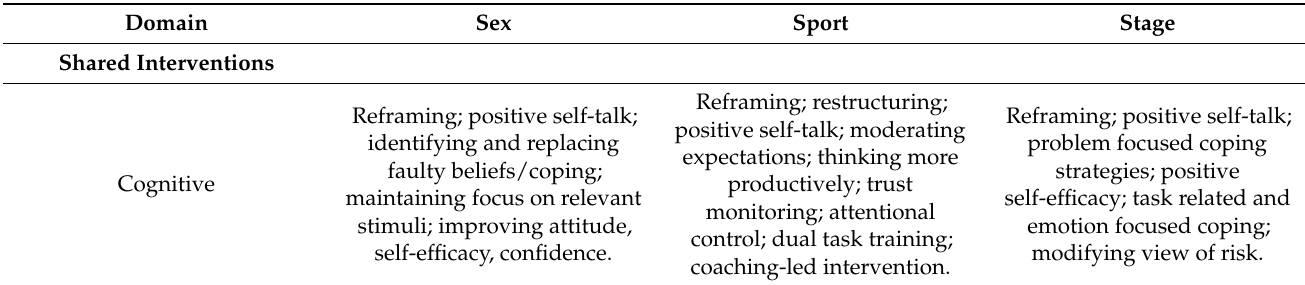
Table 1. Comparisons of common and domain-specific interventions strategies across Sex, Sport, and Stage. Domain Sex Sport Stage Shared Interventions